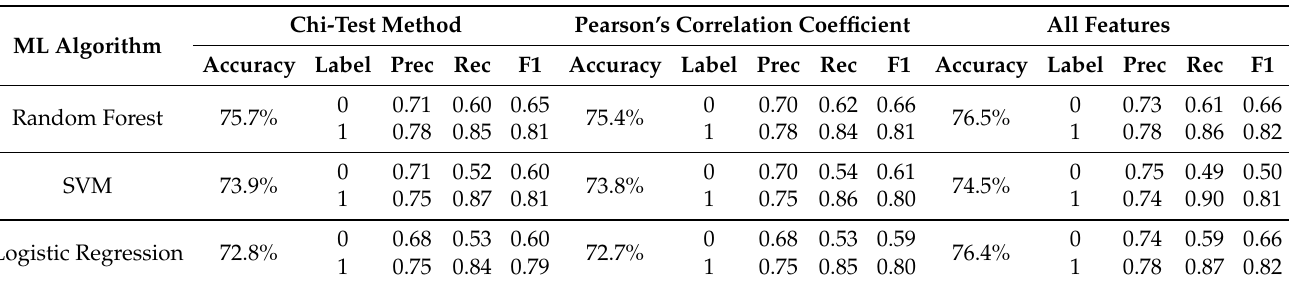
Figure 5. Confusion matrices for all the three machine-learning techniques and before and after the features’ selection. Table 3. Performance metrics before and after applying the Chi-test and Pearson’s correlation coefficient methods for all the three machine learning